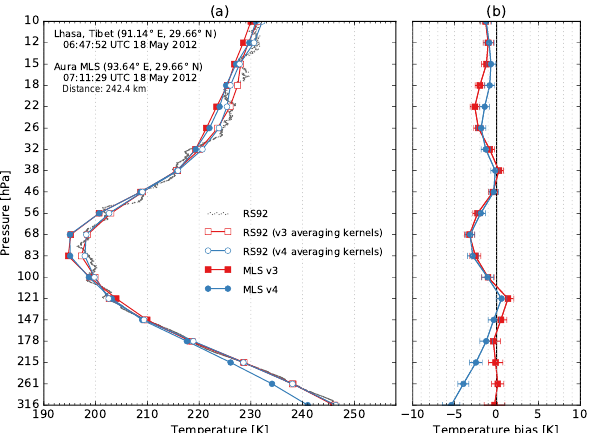
Figure 3. (a) RS92 and MLS v3 and v4 temperature profiles mea- sured at Lhasa, Tibet on 18 May 2012. The satellite overpass was offset from the launch site by 242km (0 ◦ latitude, 2.5 ◦ longitude). The balloon was launched 24min prior to the overpass and reached 191hPa at the time of the overpass. (b) Absolute biases (in K) be- tween the MLS v3/v4 profiles and the sonde profile interpolated to MLS pressure levels using the v3/v4 MLS forward functions and averaging kernels. Error bars represent the MLS measurement un-